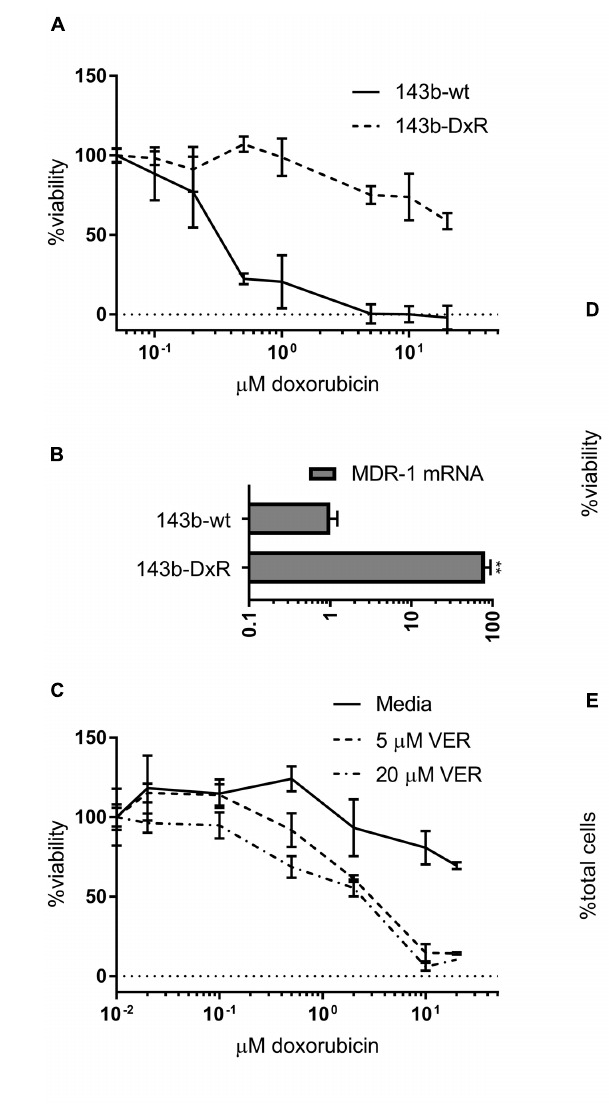
FIGURE 2 | Development and characterization of doxorubicin resistant osteosarcoma cell line (A). Viability of 143b-wt and 143b-DxR cell lines treated for 48 h with doxorubicin. ( n = 3). (B) Quantification of MDR-1 mRNA expression in 143b-wt and 143b-DxR cell lines. ( n = 3). (C) 143b-DxR cell line treated with doxorubicin and verapamil or vector. Viability assessed at 48 h. ( n = 3). (D) Viability of 143b-wt and 143b-DxR cell lines treated with FH535 for 48 h. ( n = 3). (E) Cell cycle analysis of 143b-wt and 143b-DxR cell lines after treatment with FH535 for 24 h. Data information: in (A–D) , data are presented as mean, ± SD. (B) Statistical significance determined by unpaired t -test with Welch’s correction, ∗∗ indicates p <